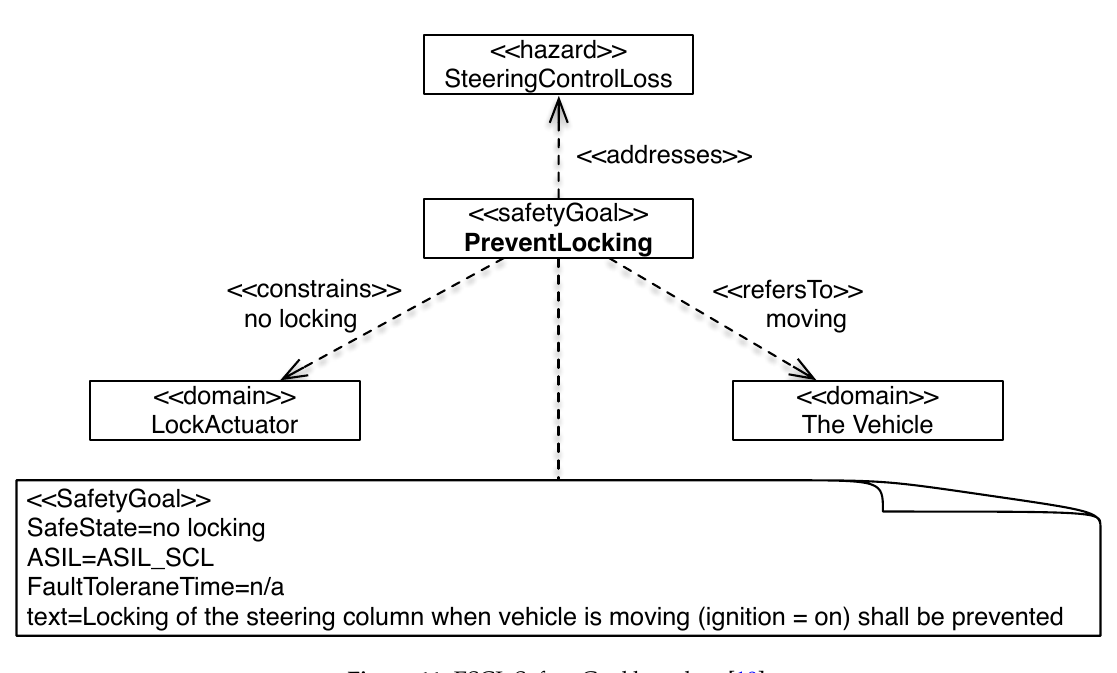
Figure 11. ESCL Safety Goal based on [10].